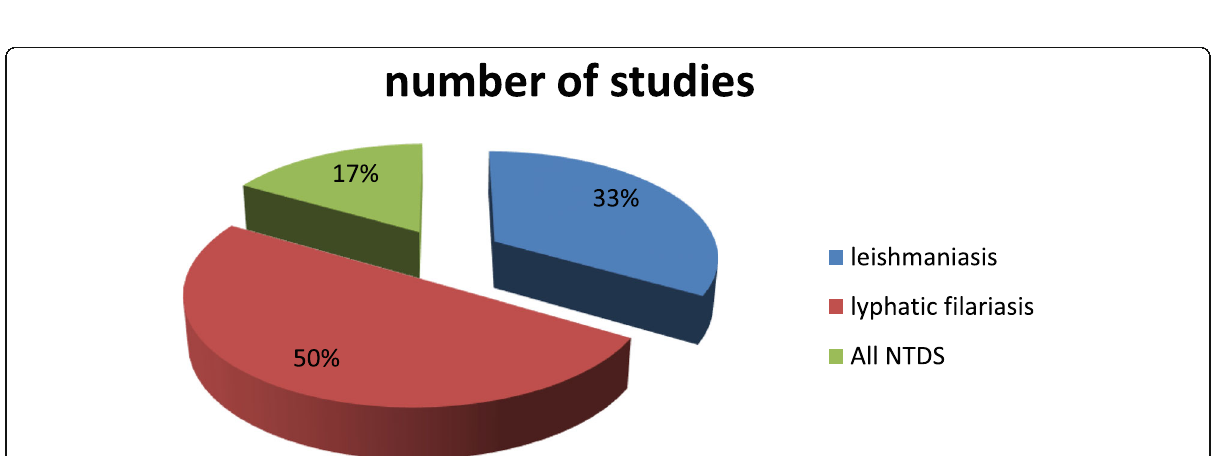
Fig. 2 Distribution of included studies by neglected tropical diseases using electronic technologies for treatment support, disease management, case finding, and case